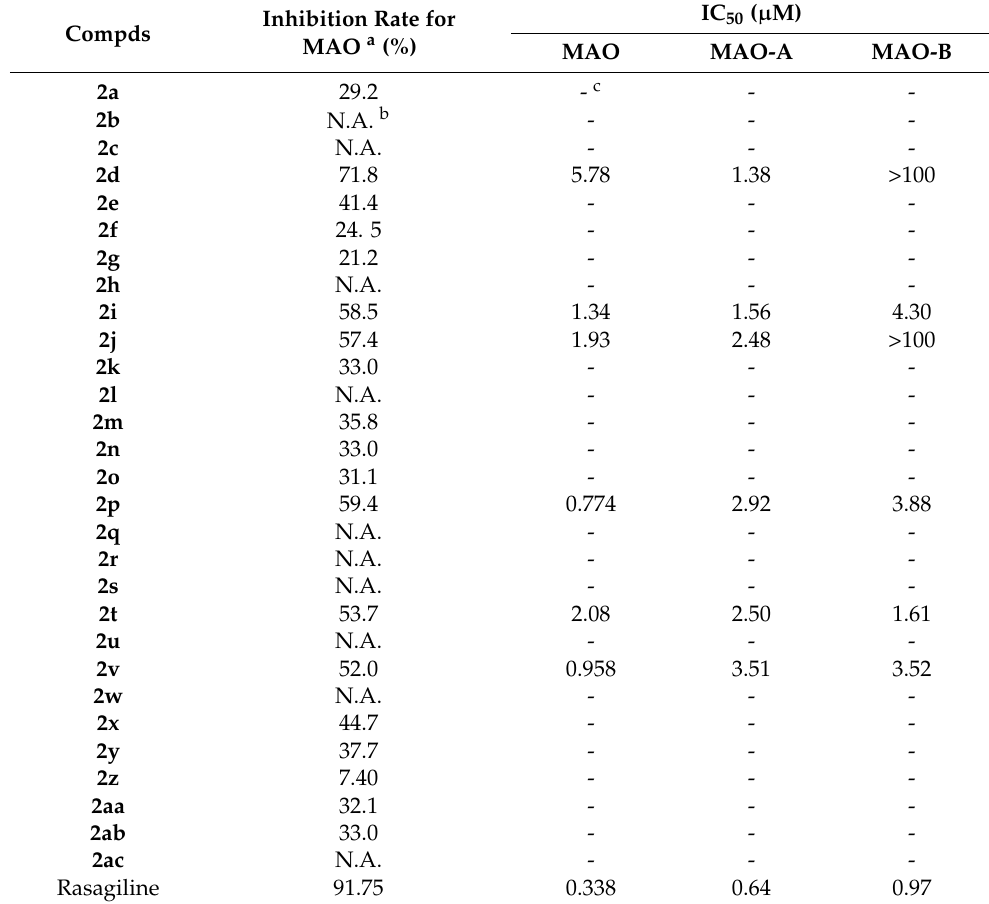
Table 1. Inhibitory activity (%) of compounds 2a – 2ac against MAO and IC 50 values of 2d , 2i , 2j, 2p , 2t , and 2v against MAO-A and MAO-B enzymes.